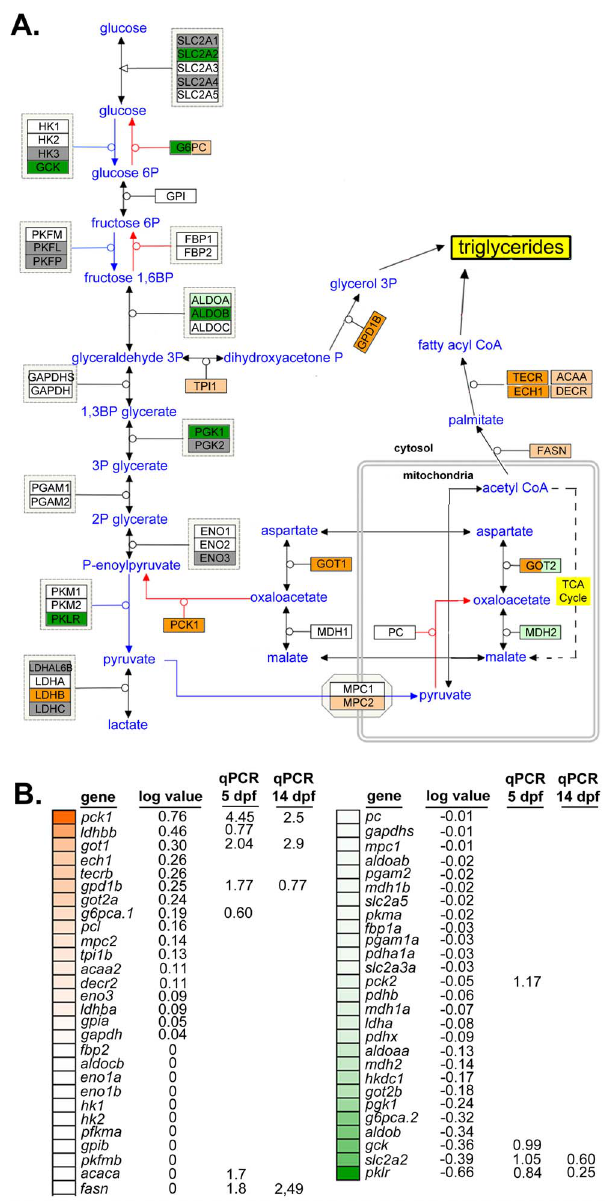
Figure 3. Glyceroneogenesis and fatty acid elongation path- ways are dysregulated by nAtf6 overexpression. Schematic of the glycolysis, gluconeogenesis and glyceroneogenesis pathway ( A , adapted from WikiPathways) and heatmap of associated genes ( B ). Upregulated genes are colored in shades of orange, downregulated genes are colored in shades of green, genes that are unchanged are white and those genes that did not appear in mRNA-Seq analyses are colored gray. Log values and median fold changes from mRNA-Seq analysis and qPCR, respectively, are noted.